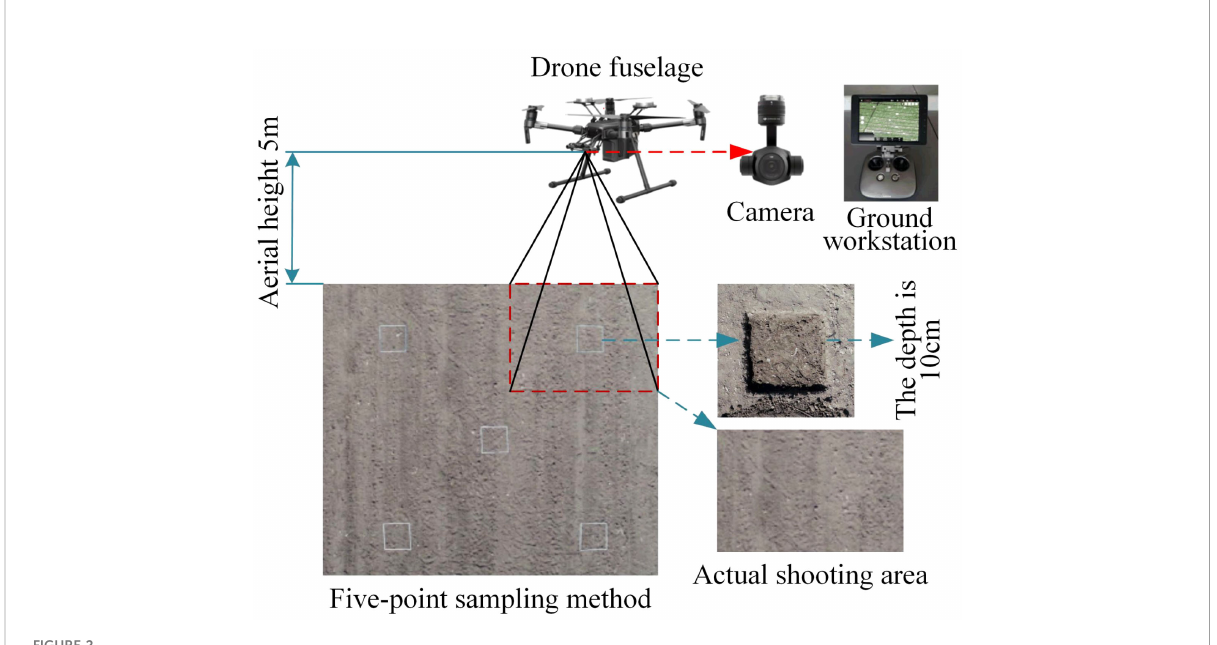
FIGURE 2 Schematic diagram of the data acquisition